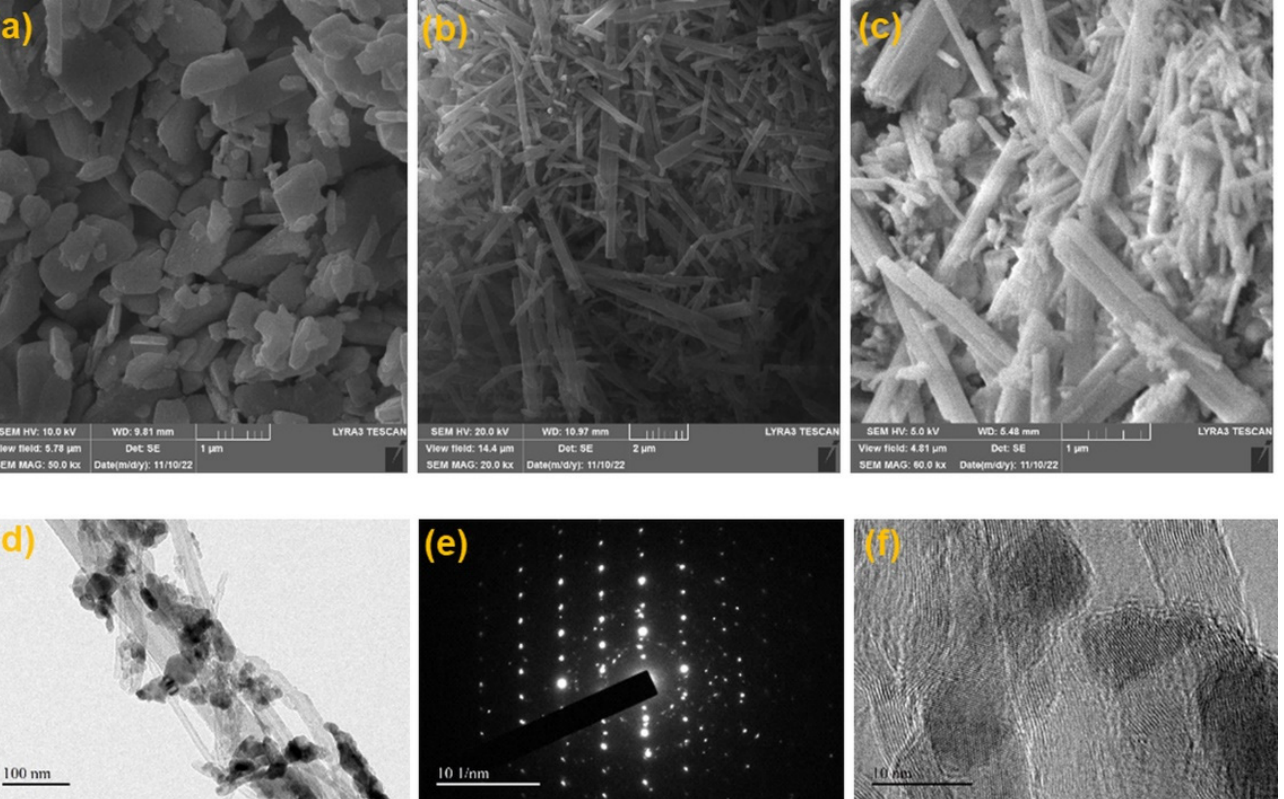
Figure 2. SEM and HR-TEM micrographs of ( a ) oblong shape g-C 3 N 4 nanosheets ( b ) CdO nanorods indicating homogenous distribution and uniform thickness of 50 − 150 nm and 1–3 ± µ m length ( c ) Nanorod-like structures of CdO-g-C 3 N 4 photocatalyst. ( d ) H-RTEM micrograph of CdO-g-C 3 N 4 nanocomposite. ( e ) SAED pattern of CdO-g-C 3 N 4 composite nanorods. ( f ) Fringe spacing of poly- crystalline CdO-g-C 3 N 4 nanocomposite.